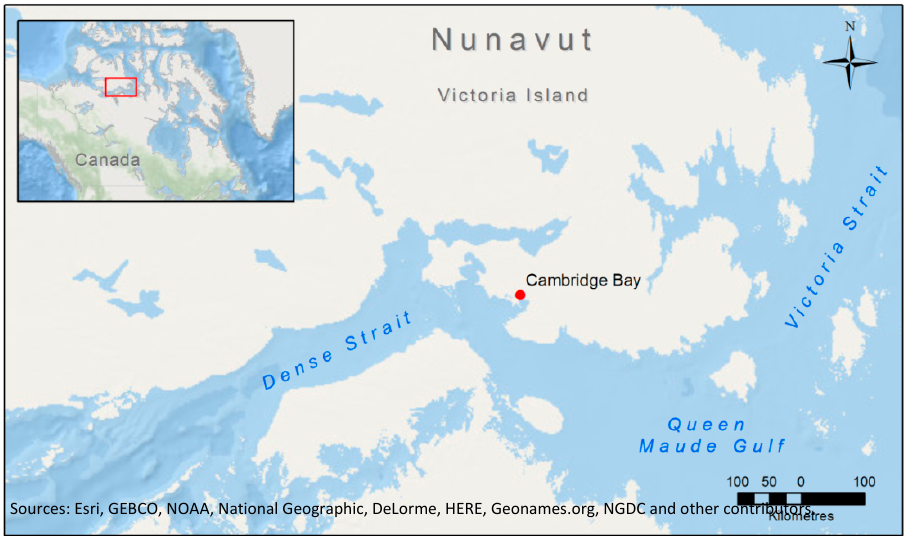
Figure 1. Location of the Cambridge Bay study site on Victoria Island, Nunavut.